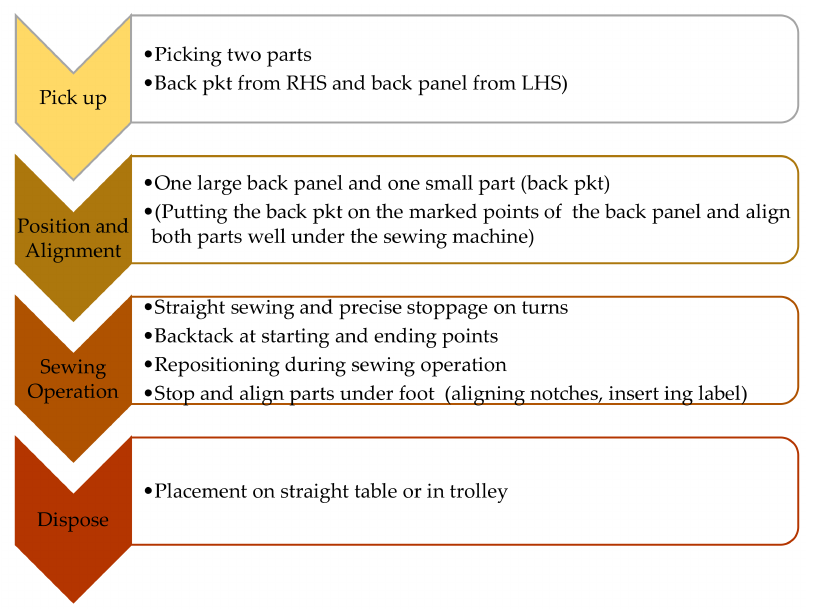
Figure 2. Back pocket operation.